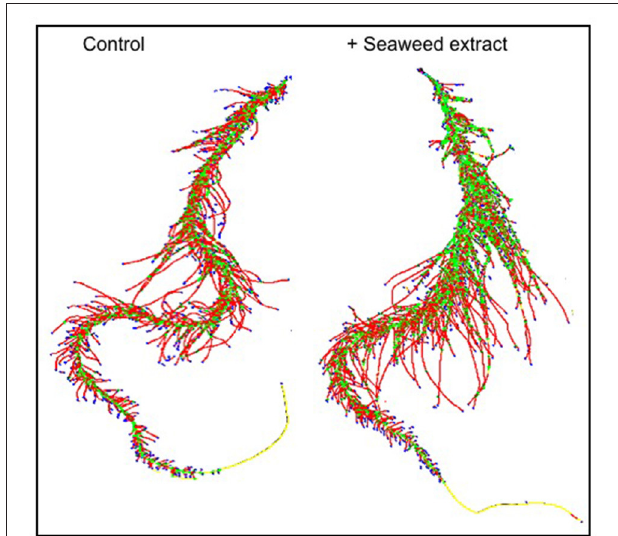
FIGURE 3 | Image comparison between roots of untreated maize plants (control) and plants treated with a seaweed extract. Image was obtained using an Epson Expression 10000XL 1.0 system (Regent Instruments Company, Canada), equipped with a root image analysis system using the software WinRHIZO.